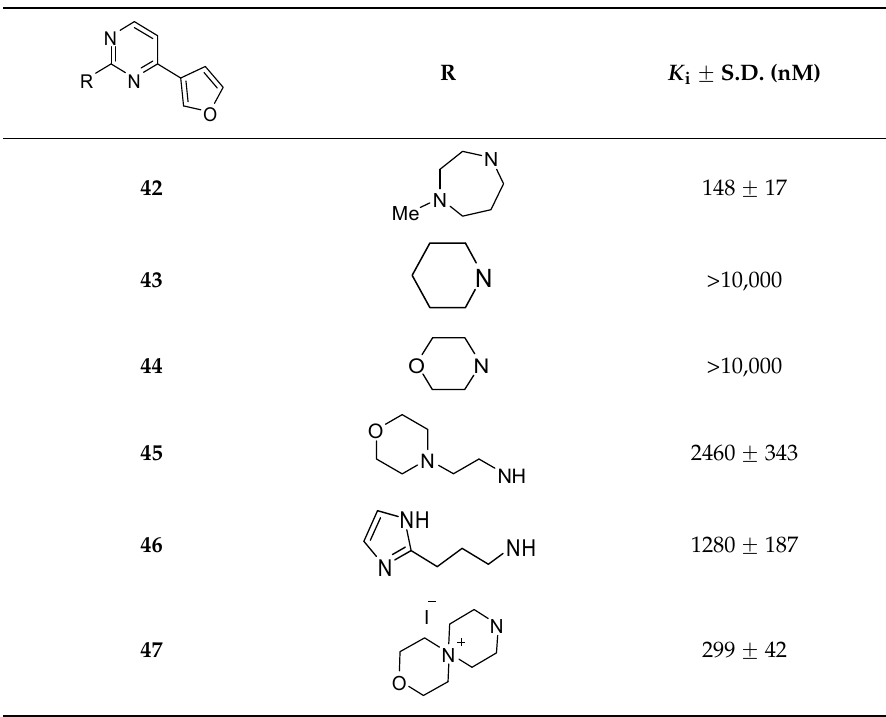
Table 3. Affinities of substituted quinazolines 48 – 50 for 5-HT 7 receptor.